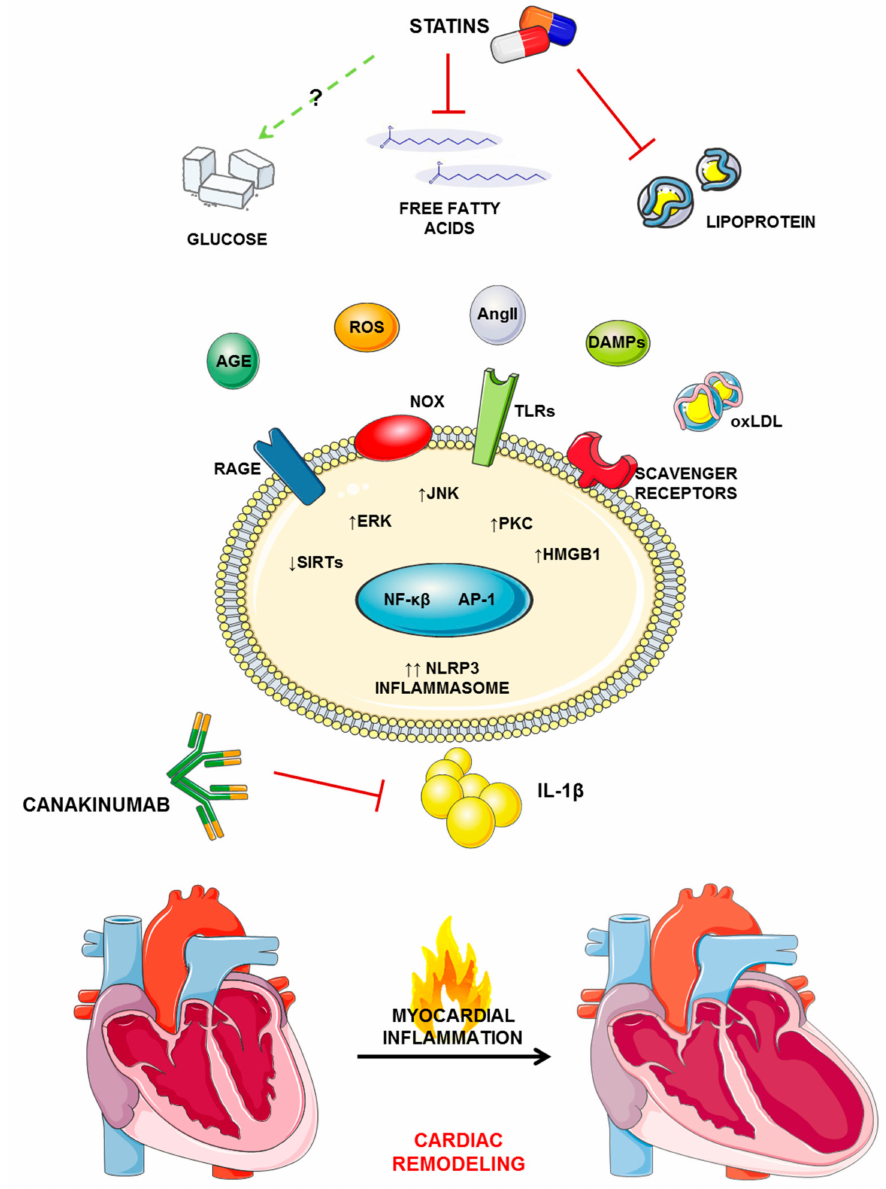
Figure 1. Altered lipid and glucose metabolisms share common molecular pathways in the pathophysiology of cardiac remodeling, relying on the release of pro-inflammatory interleukin (IL)-1 β . The increased levels of di ff erent deleterious mediators (such as AGE, AngII, DAMP, and modified lipoproteins) are sensed by promiscuous receptors on cell surfaces and trigger secondary signaling pathways leading to activation of NF- κβ and AP-1, two transcription factors involved in the regulation of NLRP3 inflammasome activity. The activated inflammasome then leads to the activation and release of IL-1 β , which fuel the sterile inflammation associated with cardiac remodeling. AGE: advanced glycation end-product; AngII: angiotensin II; AP-1: activator protein 1; DAMPs: damage-associated molecular patterns; ERK: extracellular signal-regulated kinases; HMGB1: high mobility group box 1; IL-1 β : interleukin 1 β ; JNK: Janus kinases; NF- κβ : nuclear factor kappa-light-chain-enhancer of activated B cells; NLRP3: NACHT-, LRR-, and PYD-domain-containing protein 3; NOX: NADPH oxidase; PKC: protein kinase C; TLR: Toll-like receptor; RAGE: receptor of AGE; ROS: reactive oxygen species; oxLDL: oxidized low-density